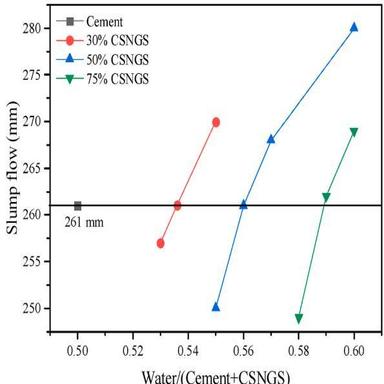
The slump flow of mortar with different w/b.